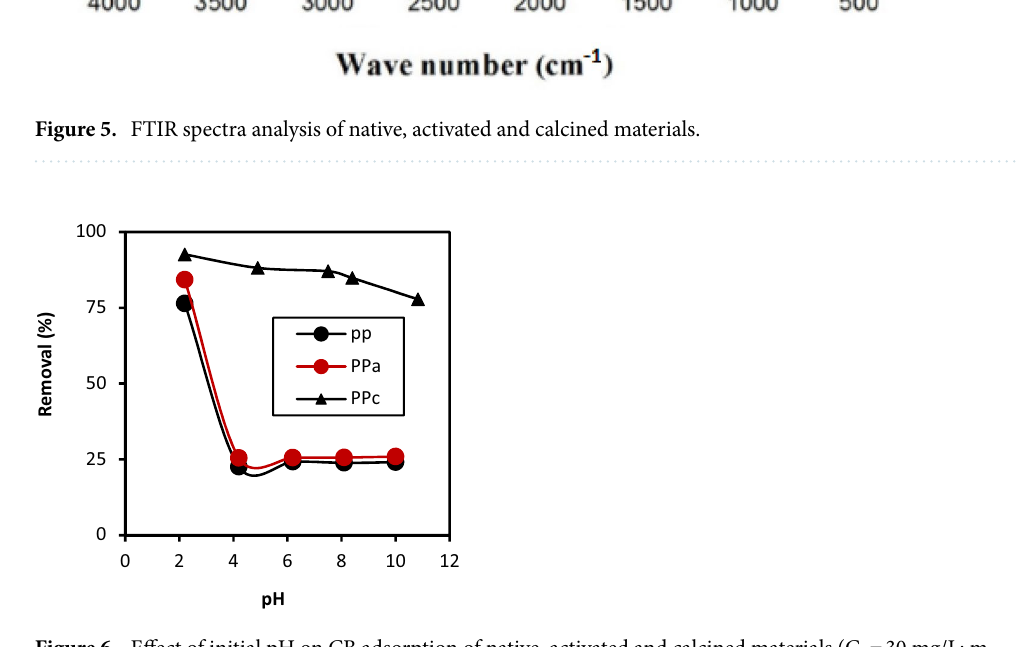
Figure 6. Effect of initial pH on CB adsorption of native, activated and calcined materials (C 0 = 30 mg/L; m (PP) = m (PPa) = 2 g/L; m (PPc) = 0.6 g/L; T = 25 ± 2